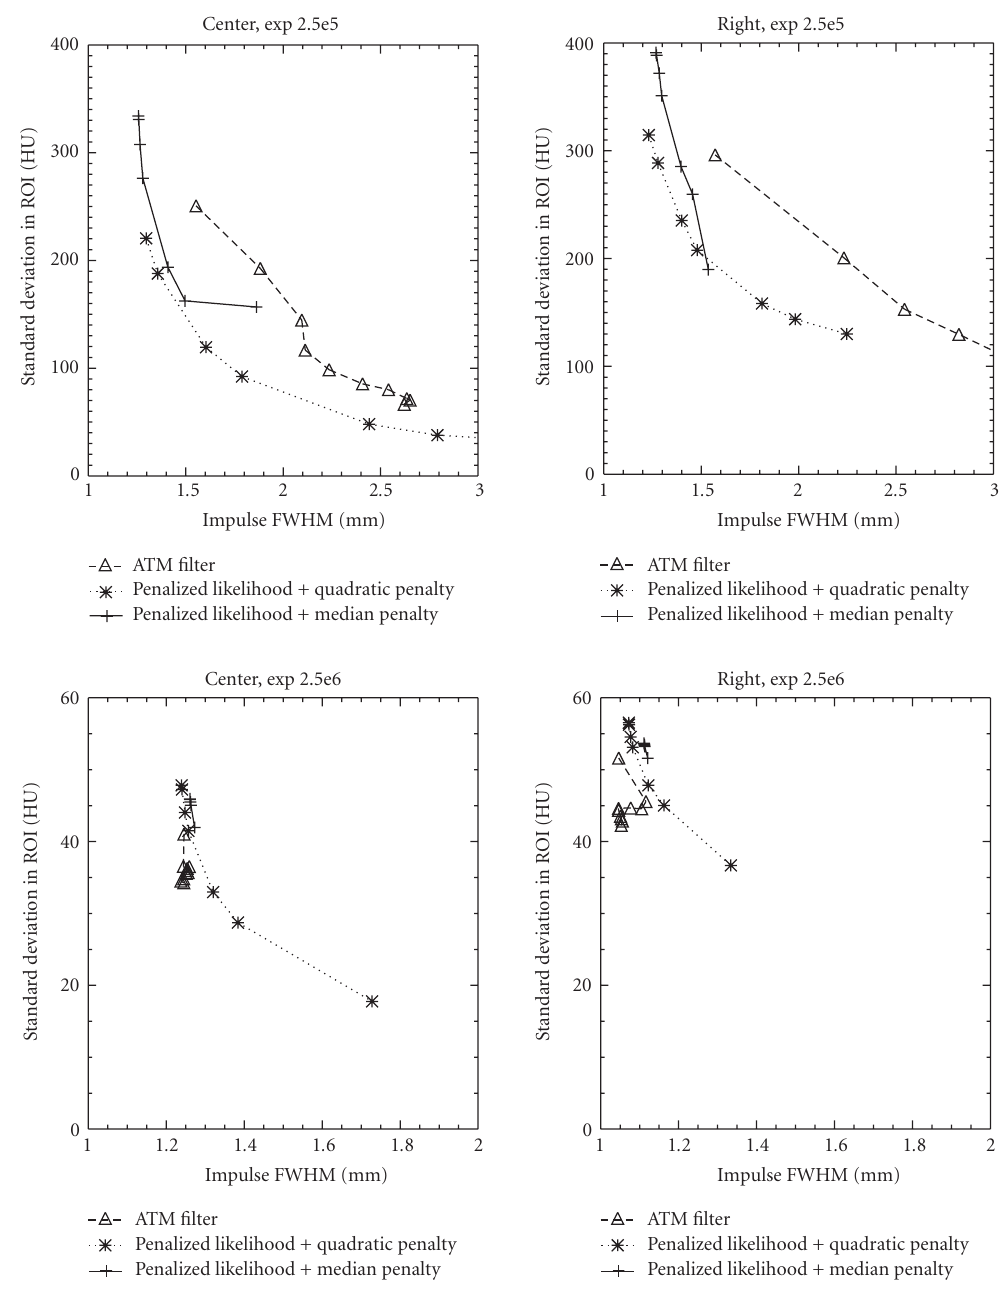
Figure 3: Resolution-noise tradeo ff s for exposures 2 . 5 × 10 5 and 2 . 5 × 10 6 at the center and right circular inserts in the ellipse phantom for the three approaches under